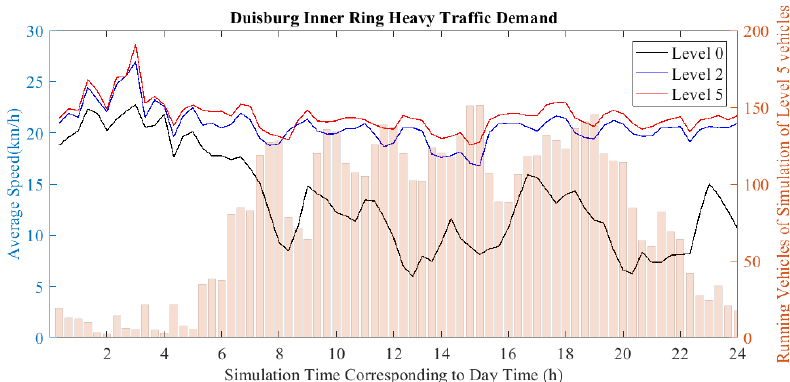
Figure 9. Comparison of the average speed of vehicles with different automation levels in heavy traffic volume (150% traffic